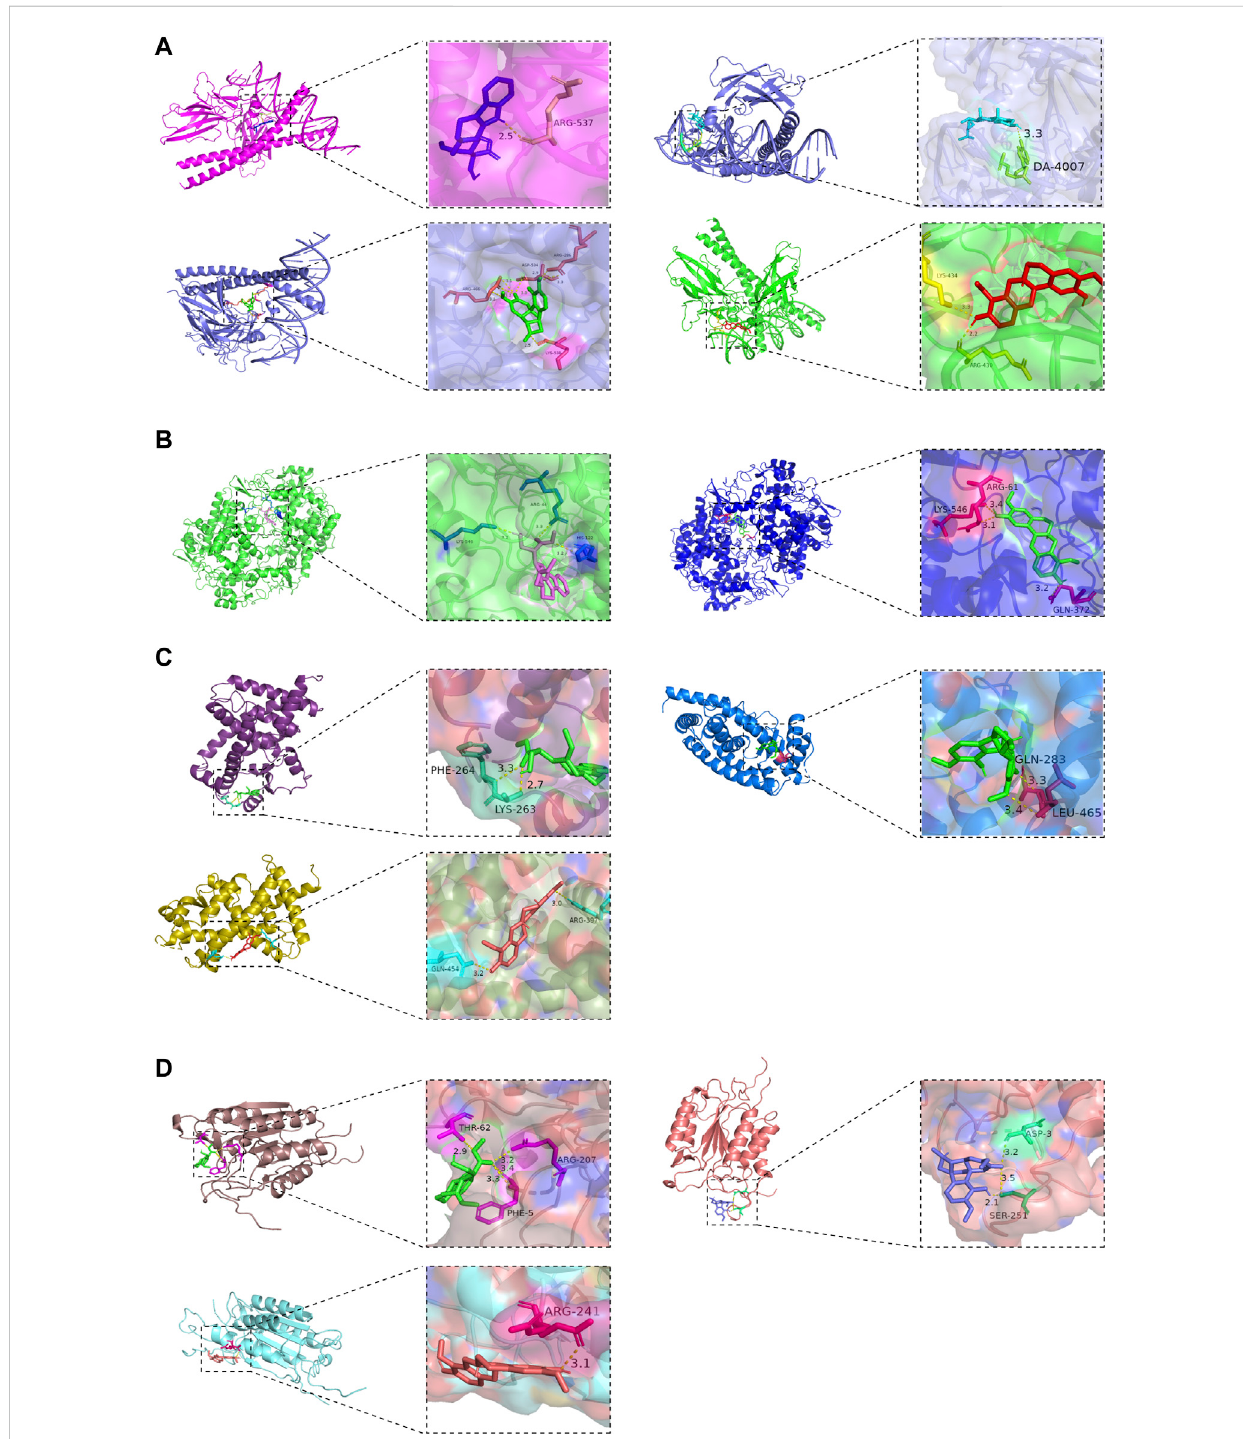
FIGURE 9 MoleculardockingoftheactiveingredientsofSAwithkeytargets. (A) JUNtargetishydrogen-bondedtotheactiveingredientofSA; (B) PTGS2target is hydrogen-bonded to the active ingredient of SA; (C) PPARG target is hydrogen-bonded to the active ingredient of SA; (D) CASP3 target is hydrogen- bonded to the active ingredient of SA.